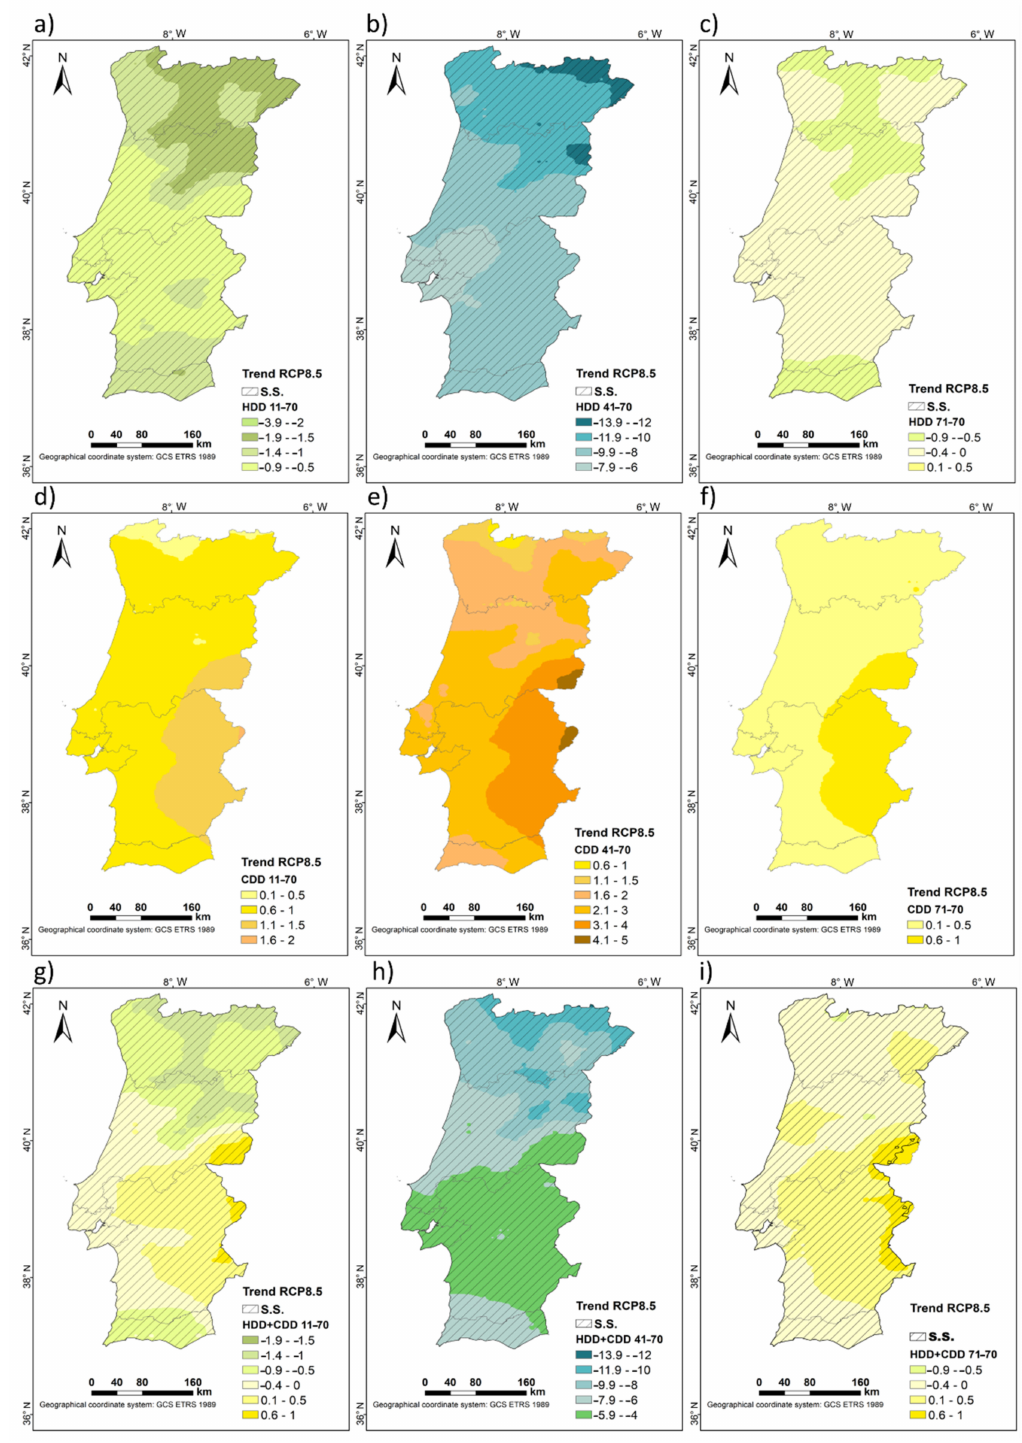
Figure 9. Statistically significant (S.S.) linear trends (at a 95% confidence level) of ( a – c ) HDD per year, ( d – f ) CDD per year, and ( g – i ) HDD + CDD per year under RCP8.5 for 2011–2070 (left), 2041–2070 (center) and 1971–2070 (right). The projected decrease of HDD for Portugal is significantly larger for 2041–2070 under RCP8.5 (Figure 9b) than under RCP4.5 (Figure 8b). This statistically significant de- crease is more pronounced towards North for all periods although with greater expression for 2041–2070 where values range from ( − 13.5 to − 6 days per year) under RCP8.5 and ( − 9.9 to − 2 days per year) under RCP4.5. Though statistically significant for the